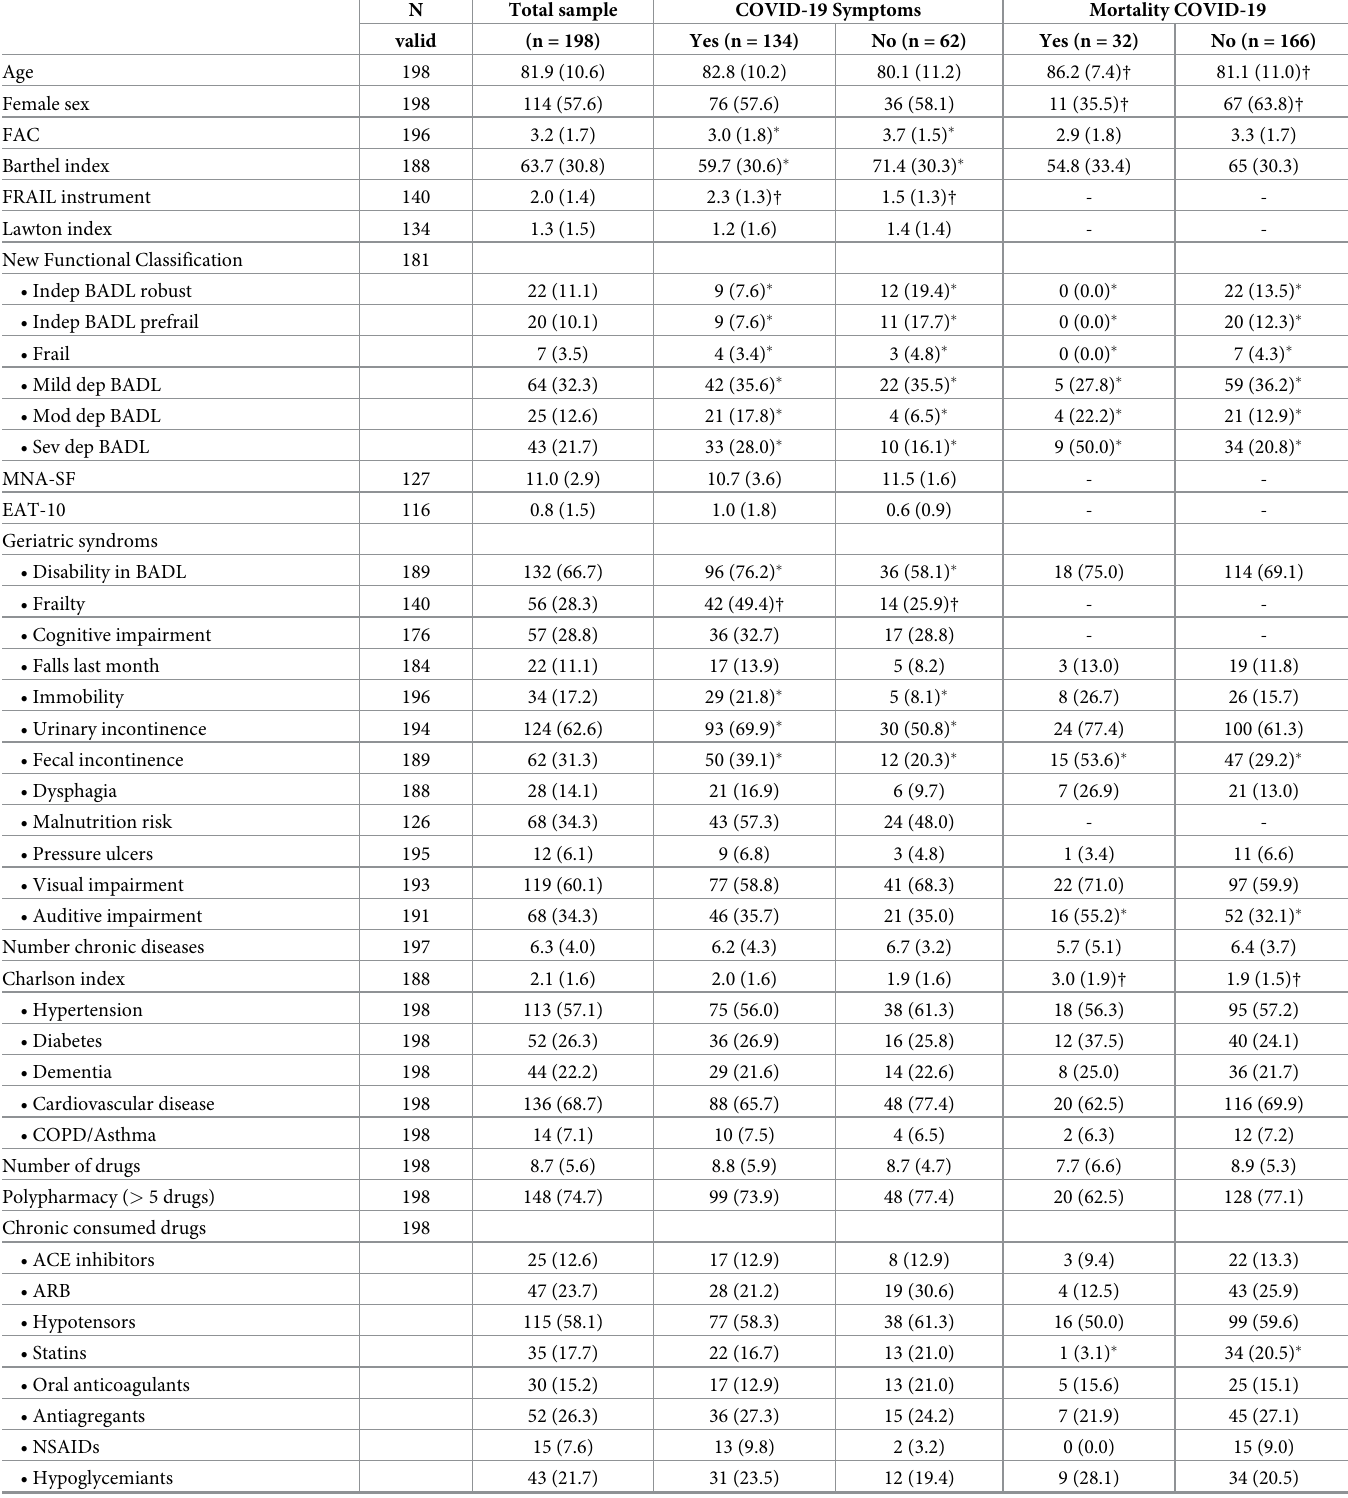
Table 2. Clinical characteristics of residents in facility